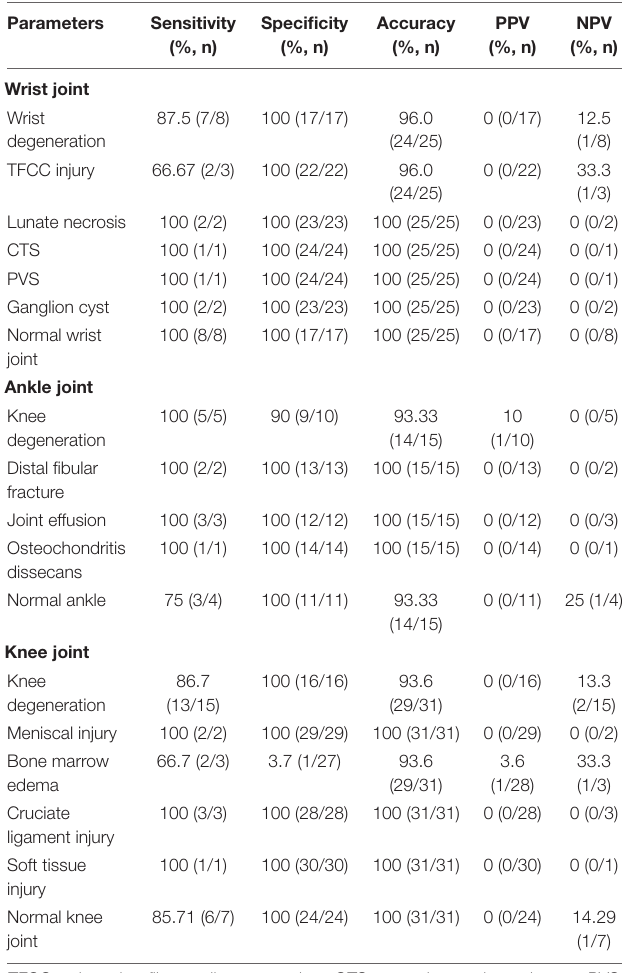
TABLE 4 | Comparison of the diagnostic performance of wrist, ankle, and knee joints between the routine turbo spin-echo (TSE) and simultaneous multi-slice (SMS)-TSE